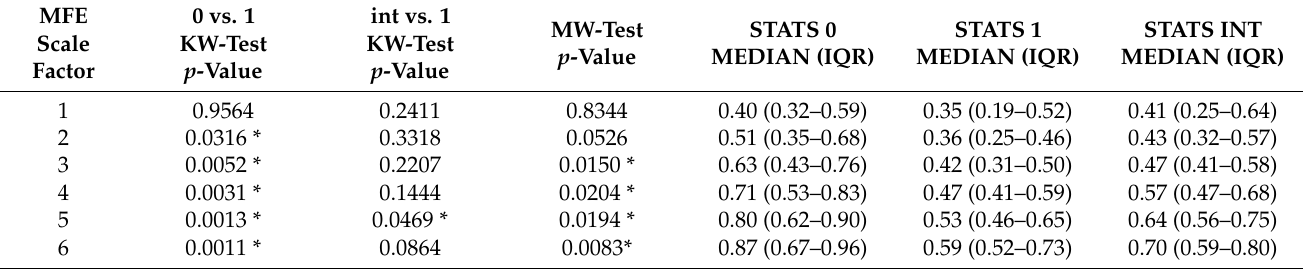
Table 4. Multiscale Fuzzy Entropy—Statistical results of the test described in Section 2.6. The descriptive statistics (median and IQR) related to the three groups considered (0, 1, and int) are reported. Star (*) denotes statistically significant results.